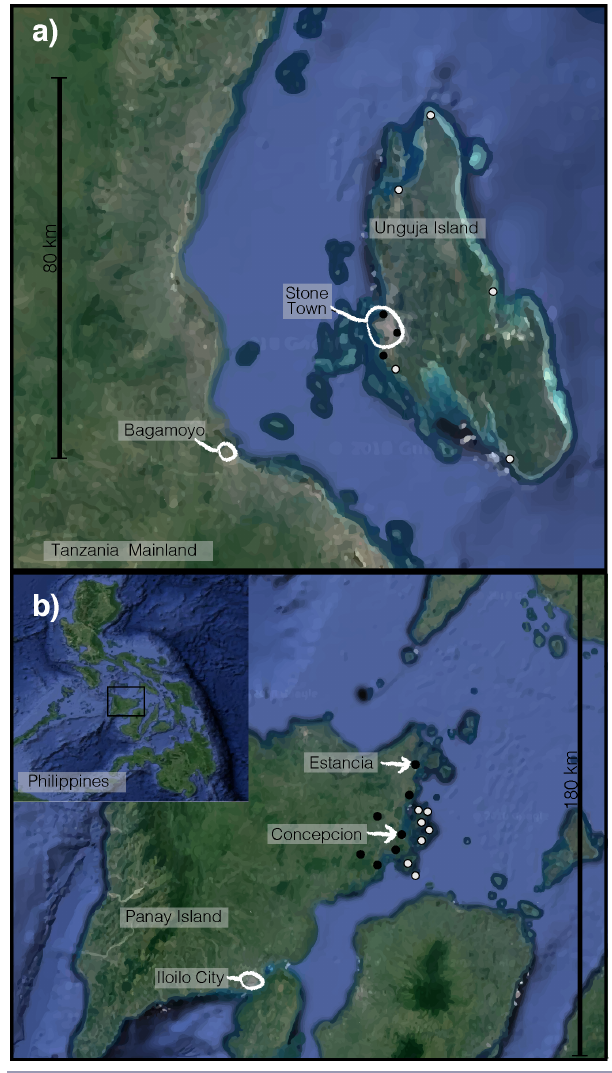
Fig. 1 . (a) Map of Unguja Island, Zanzibar with eight sampling sites (indicated by dots), and one on mainland Tanzania (left); (b) Map of Panay Island (larger picture) in respect to the rest of the Philippines (inset). Study sites are centered around Concepcion in the north, with 15 sites including markets, and central port areas on Panay Island, as well as offshore islands. Black dots in both countries represent urban sites and white dots rural